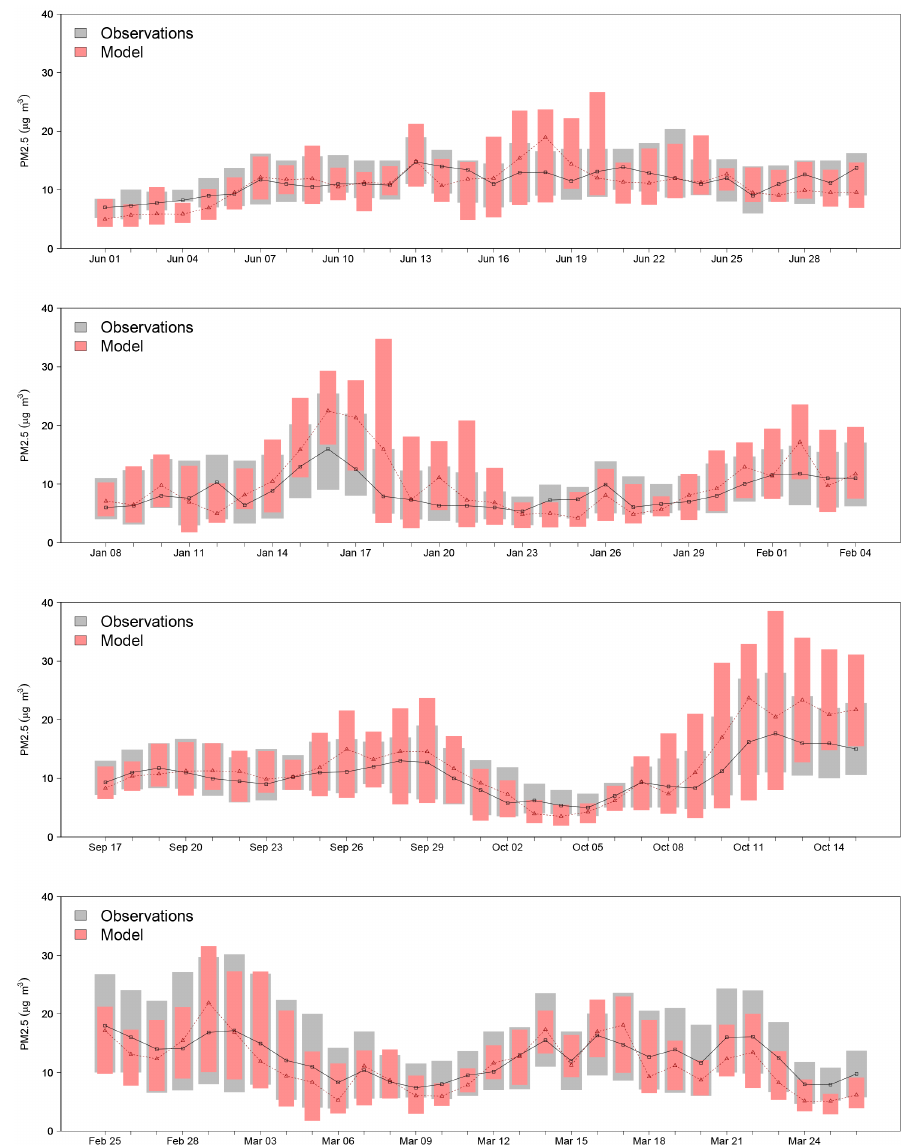
Figure 2. Comparison of modelled (red) and measured (grey) PM 2 . 5 concentrations at AirBase rural-background sites. The extent of the bars indicates the 25th and 75th percentiles. The black and red lines are observed and modelled medians, respectively. The numbers of sites are 48, 56, 90 and 110 from top to bottom. Based on the base case